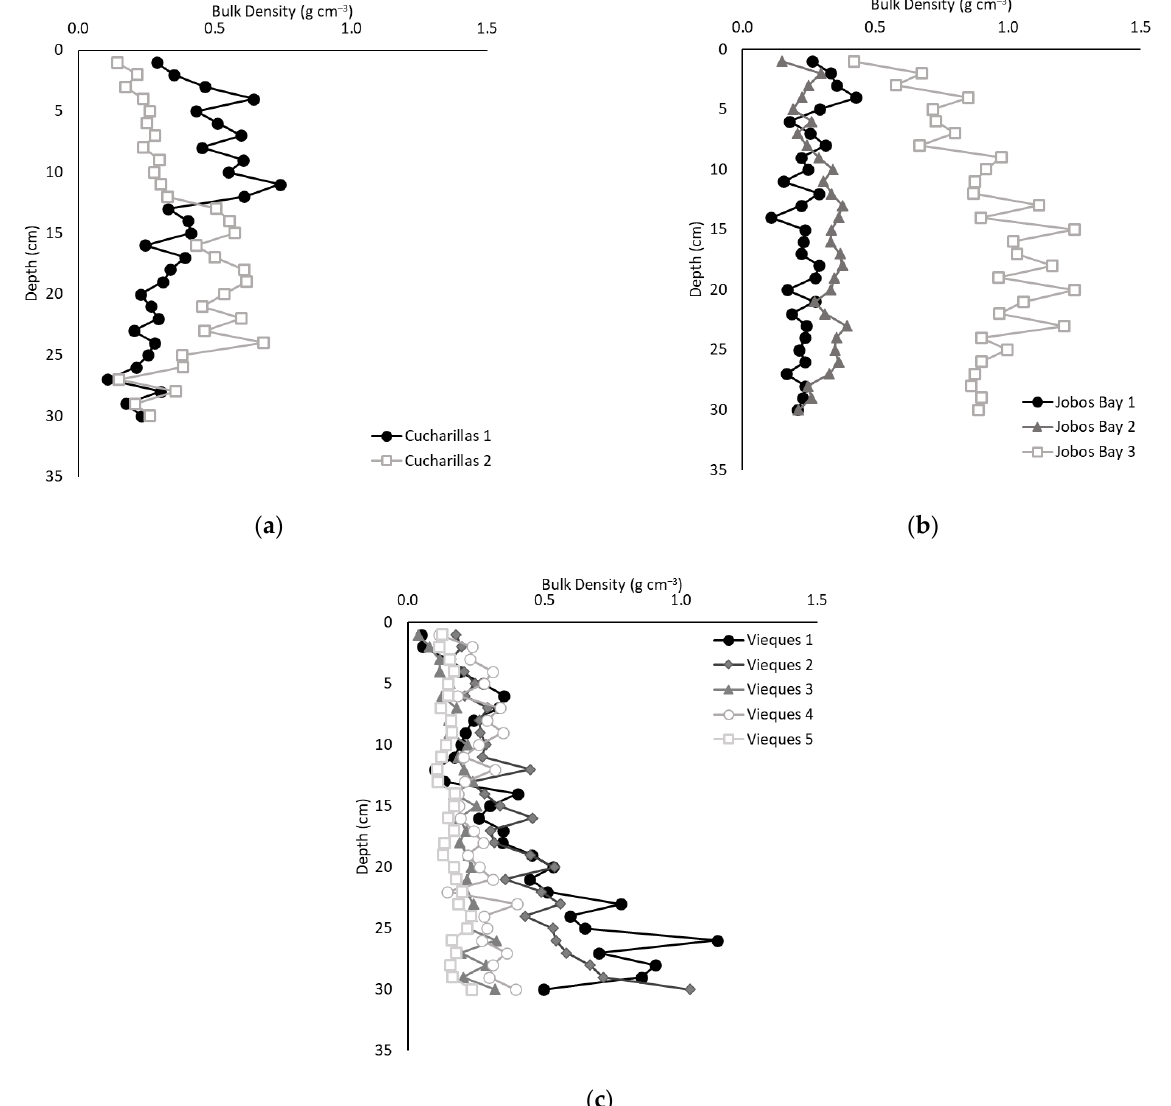
Figure 1. Average bulk density of soil at each 1 cm of depth at ( a ) Cucharillas, ( b ) Jobos Bay, and ( c ) Vieques. At Cucharillas, there was no significant difference of bulk density between the two sites (Wilcoxon, p = 0.99). At Jobos Bay, Jobos Bay 1 and 2 did not have statistically differ- ent bulk density values (0.24 ± 0.06 g cm −3 and 0.30 ± 0.06 g cm −3 , respectively), but Jobos Bay 3, the site furthest from the open water, which received sediments from surface flow irrigation for sugarcane production until the 1970s, had a statistically greater bulk density which averaged 0.91 ± 0.03 g cm −3 (Kruskal-Wallis, p < 0.01). At Vieques, the two sites closest to the open water (Vieques 1 and 2) had the greatest bulk density (0.41 ± 0.27 g cm −3 and 0.39 ± 0.04 g cm −3 , respectively). They were not statistically different from one another (Kruskal-Wallis, p = 0.77), but they were significantly greater than the other three sites (Kruskal-Wallis, p < 0.01). 2.3. Soil Carbon Content Total organic carbon (TOC) content ranged from 28 to 207 g-C kg −1 with an average of 141.9 ± 3.9 g-C kg −1 across all sites and depths (Figure 2). TOC content was statistically higher at Vieques (15.1 ± 0.5%) and Cucharillas (15.4 ± 1.07%) than at Jobos Bay (11.8 ±